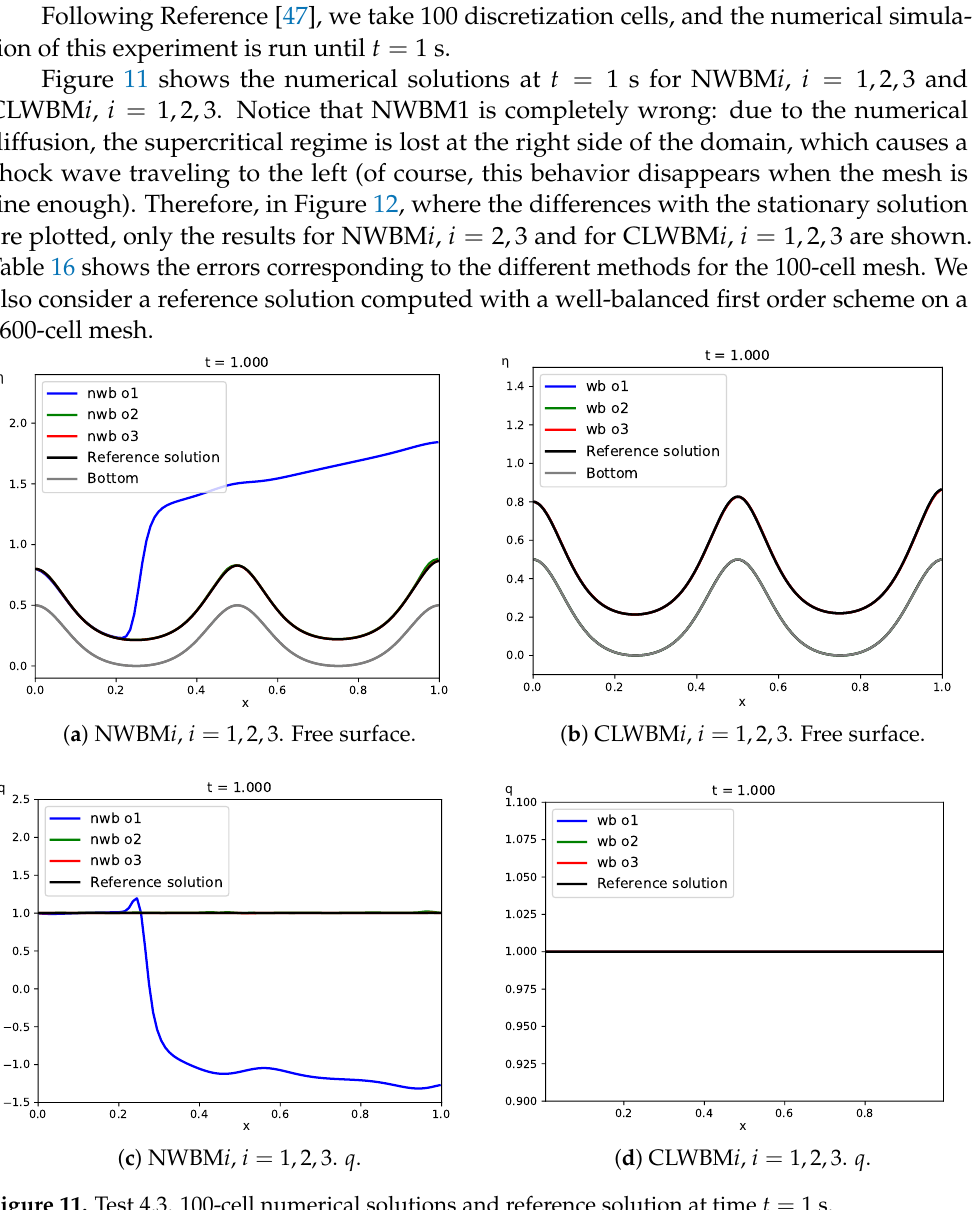
Figure 11. Test 4.3. 100-cell numerical solutions and reference solution at time t = 1